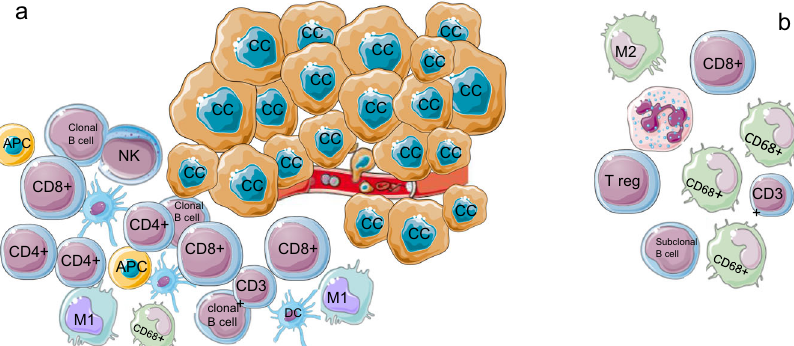
Fig. 2 Tumor microenvironment. a Immune-stimulating microenvironment with homogeneous distribution of CD8 + and CD4 + T cells, M1 polarized macrophages, APC and dendritic cells, in proximity with cancer cells. b Immune-escaping microenvironment with higher ratio of CD68 + :CD3 + T cells, and M2 polarized macrophages, and more distance between cancer and immune cells. CD4 + and CD8 + :Tcells marker; CD68 + : pan-macrophage marker; APC: antigen presenting cells; CC: cancer cells; DC: dendritic cells. Figure includes modi fi ed templates from Servier Medical Art